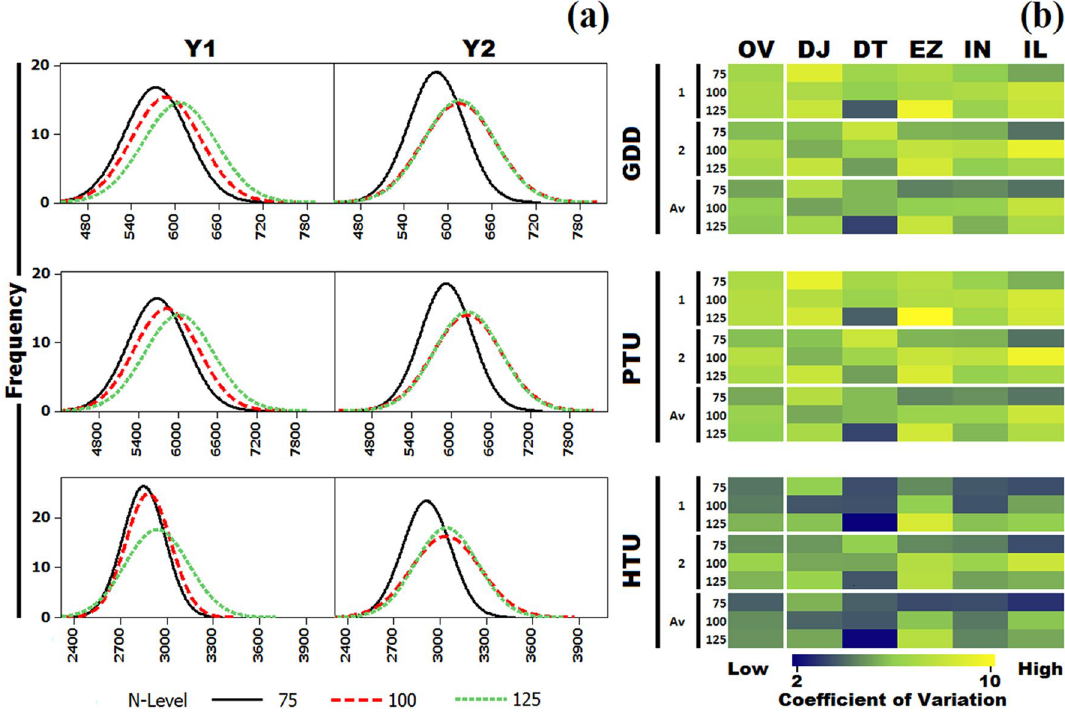
Figure 4. (a) Phenotypic variations for growing degree days (GDD), photo-thermal units (PTU) and Helios thermal unit (HTU) at initiation of flowering in the B. juncea diversity panel; (b) coefficient of variations for GDD, PTU and